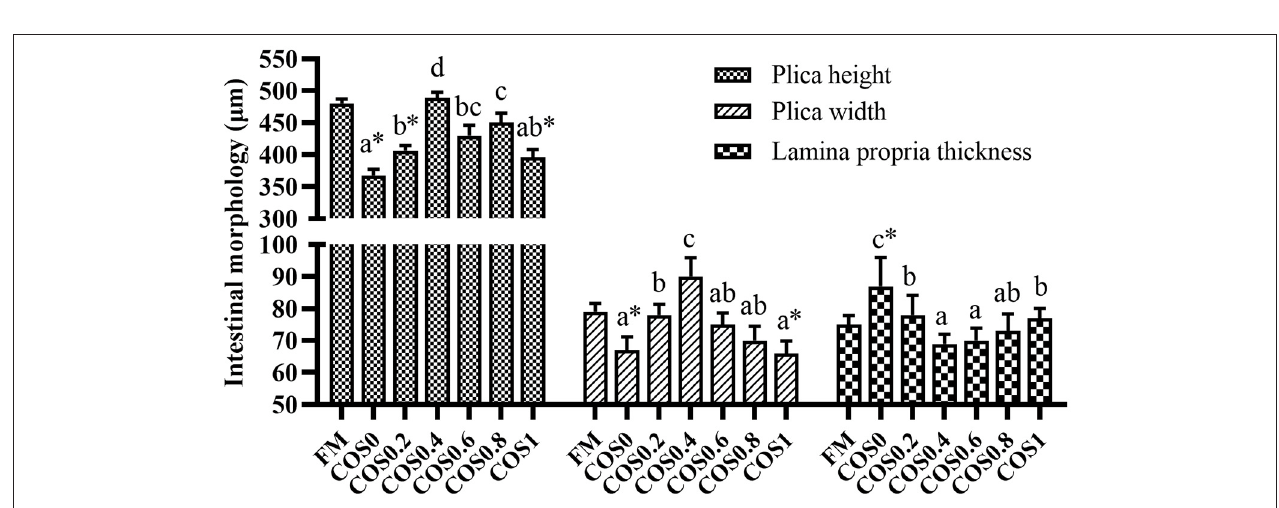
FIGURE 3 | Intestinal morphology measurement of grouper( µ m). Randomly selected 10 folds and lamina propria in each slice for measurement. Values are means ± SEM ( n = 3). Values in the same row with different superscript letters mean significantly different among COS-containing groups ( P < 0.05). The superscript * indicates that this COS-containing group is significantly different from FM group ( P <